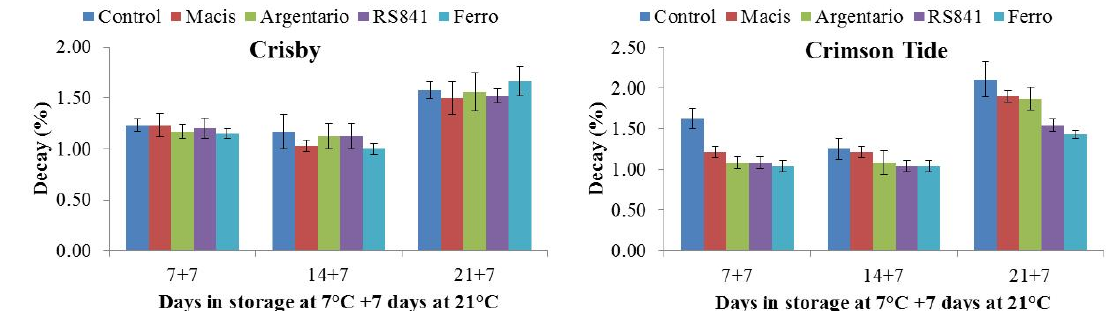
Fig. 3: Effects of rootstocks on fungal decay of ‘Crisby’ and ‘Crimson Tide’ watermelon fruits after shelf life period for 7 days at 21 °C following storage at 7 °C